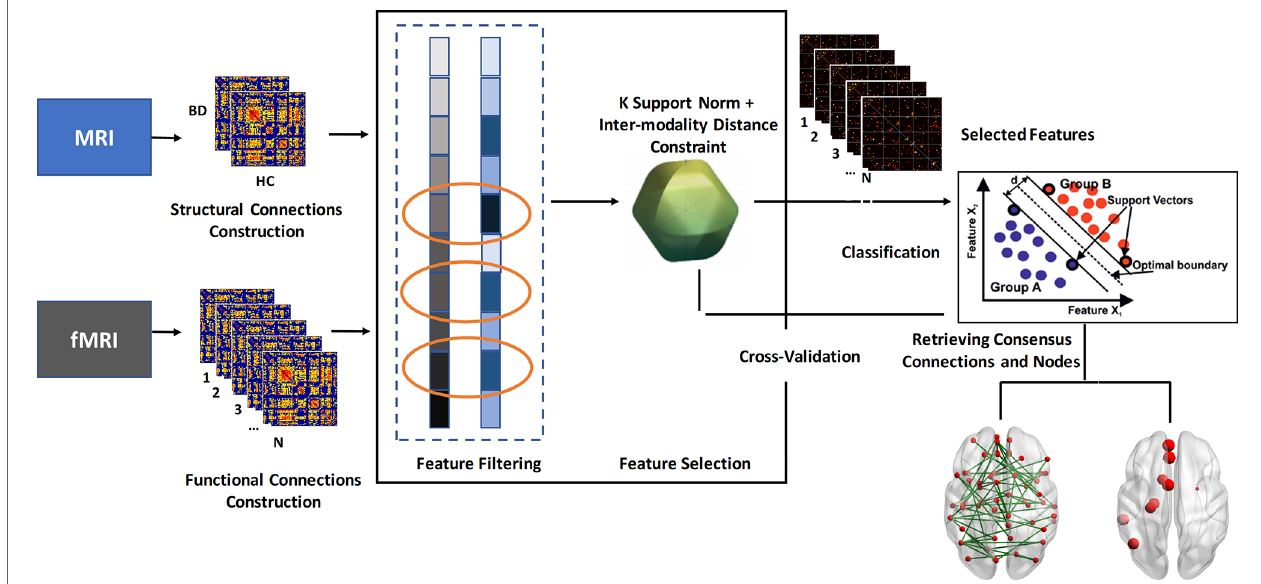
FIgURE 1 | Flowchart of the multivariate analysis method in this study. BD, bipolar disorder; HC, healthy